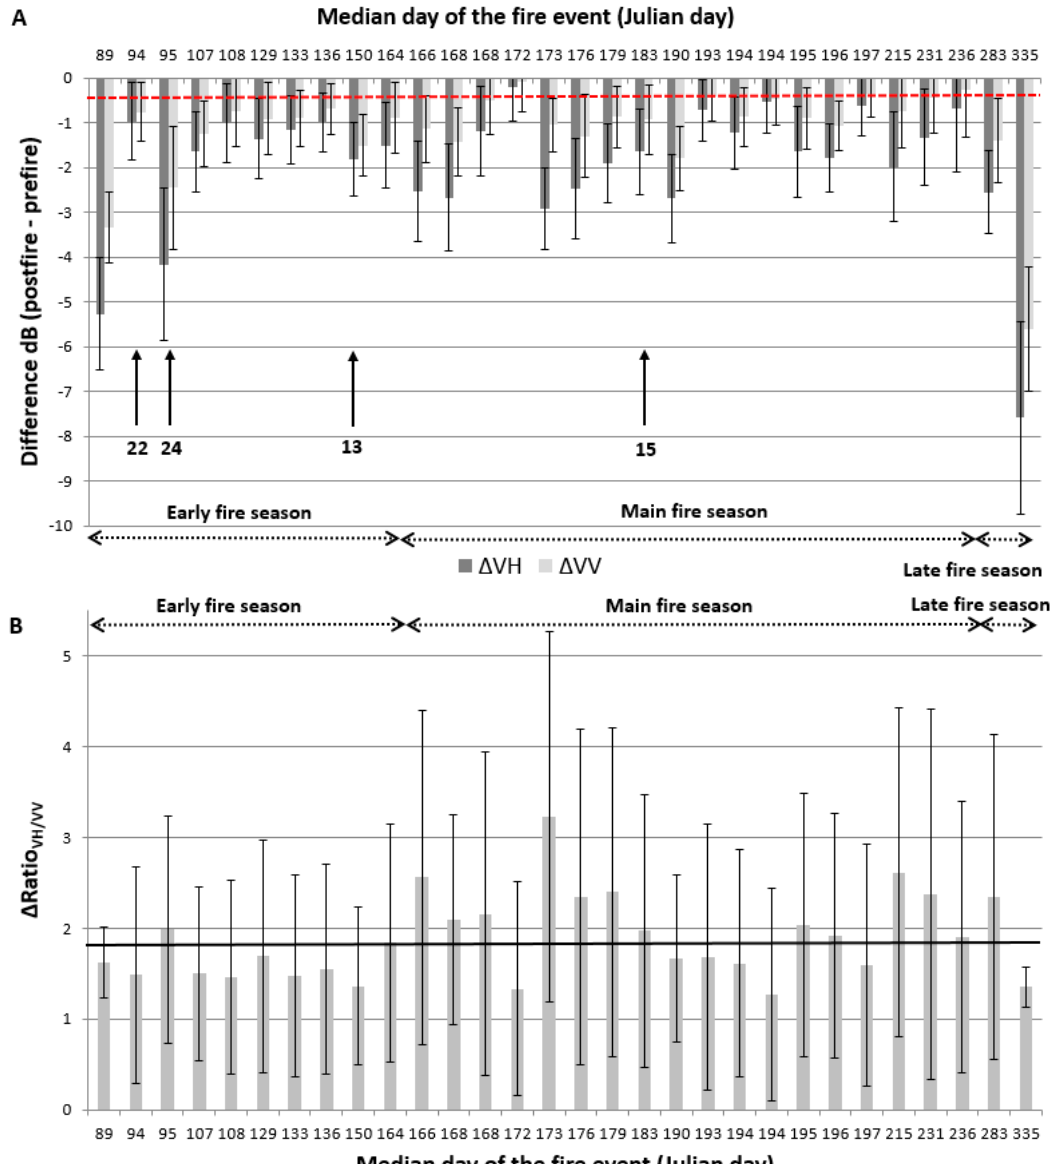
Figure 8. ( A ) Mean pre-fire to post-fire backscatter di ff erences ∆ VV and ∆ VH for each of the 30 KNP burn events in 2015, ( B ) ratio of the mean VH and VV di ff erences ∆ ratio VH / VV . Whiskers shows the standard deviation. The horizontal dashed red line in A shows the Sentinel1-A radiometric accuracy reported by [68], 0.43dB. The numbers and vertical arrows in (A) refer to the burn events illustrated in Figure 11. The plain line in (B) shows the mean ∆ ratio VH / VV for all 30 KNP burn event.